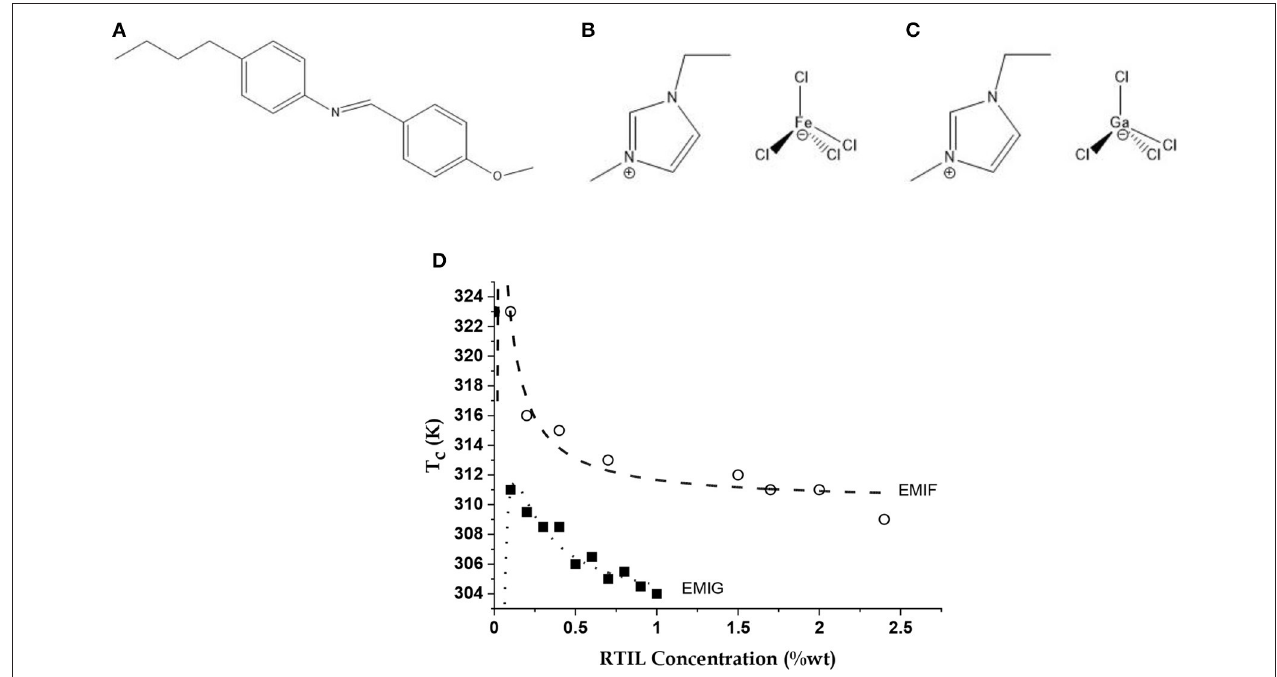
FIGURE 1 | The molecules and their equilibrium property. Molecular structures of the liquid crystal (LC) (A) n -(4-methoxybenzylidene)-4-butylaniline (MBBA), and the room temperature ionic liquids (RTILs) (B) 1-ethyl-3-methylimidazolium tetrachloroferrate (EMIF) and (C) 1-ethyl-3-methylimidazolium tetrachlorogallate (EMIG); (D) Variations of Nematic-Isotropic transition temperature ( T c ) of LC-RTIL mixtures with EMIF and EMIG concentrations shown as open circles and filled squares, respectively. Data simulated (dashed and dotted lines, respectively) with a model of the MBBA dipoles screened by RTIL ions taking into account the self-screening of the ions [5] using Equation (1). See text for